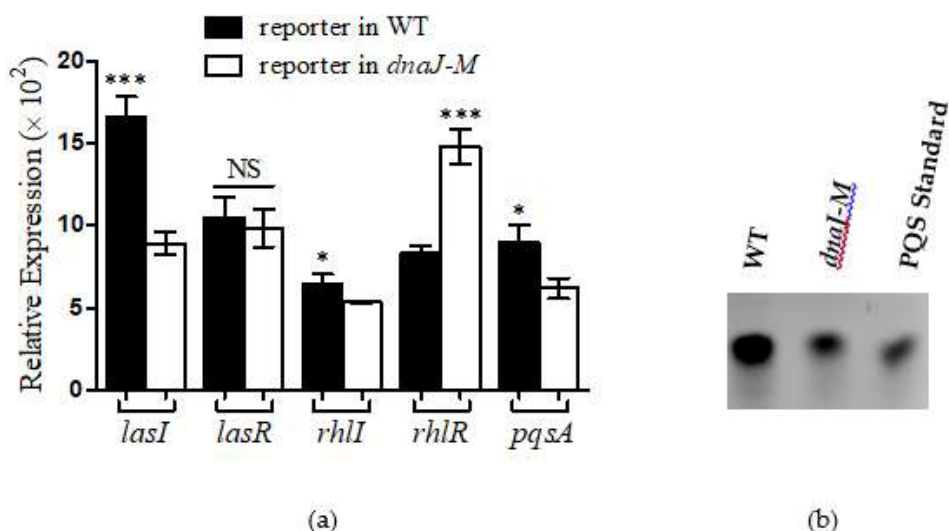
Figure 6. The effect of dnaJ on quorum sensing (QS) genes and 2-heptyl-3-hydroxy-4(1H) -quinolone (PQS) signal production. ( a ) The expression of lasI, lasR, rhlI, rhlR and pqsA was compared between the wild-type, PAO1 (black), and the mutant strains, dnaJ-M (white). The expression levels presented are cps-normalized to OD 600 . Averages of triplicate experiments ± standard errors of the means are shown. Two-tailed unpaired t -test was performed using GraphPad software version 5.0 (*, p < 0.05; **, p < 0.01; ***, p < 0.001). NS: Not Significant. ( b ) Comparison of PQS production between the WT and dnaJ-M . PQS in the cultures was isolated and analyzed on high performance thin layer chromatography (TLC). Extract from 500 µL of culture equivalent was loaded onto the TLC plate.